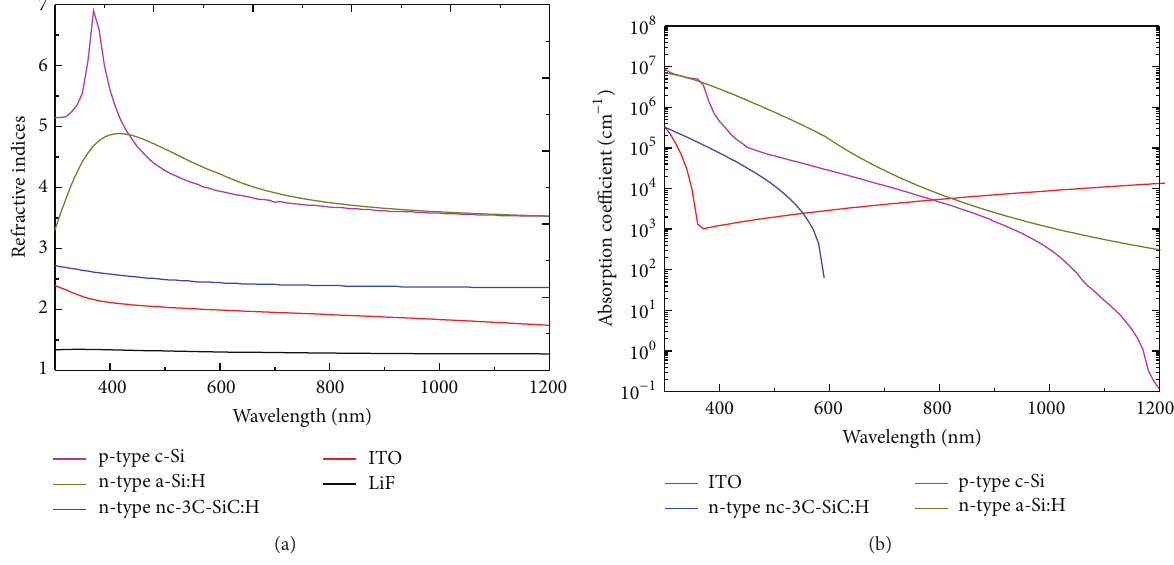
Figure 2: (a) The refractive indices of c-Si, emitter layers, ITO, and LiF used in the simulation. (b) The absorption coefficient of c-Si, emitter layers, ITO, and LiF used in the